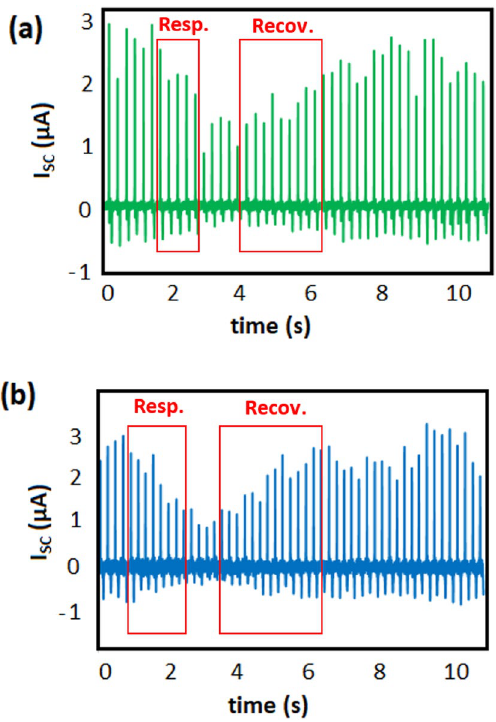
Figure 8. Dynamic response of porous PDMS ( a ) and CNT-PDMS ( b ). Recovery and response times of humidity sensing are indicated.